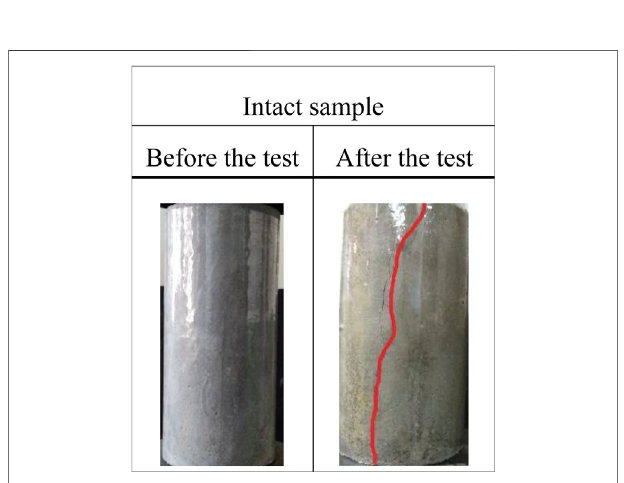
FIGURE 12 | Failure mode of the cracked samples for intact